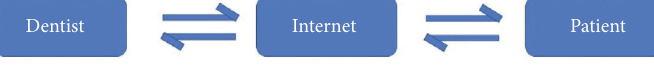
Figure 1: Real-time consultation.